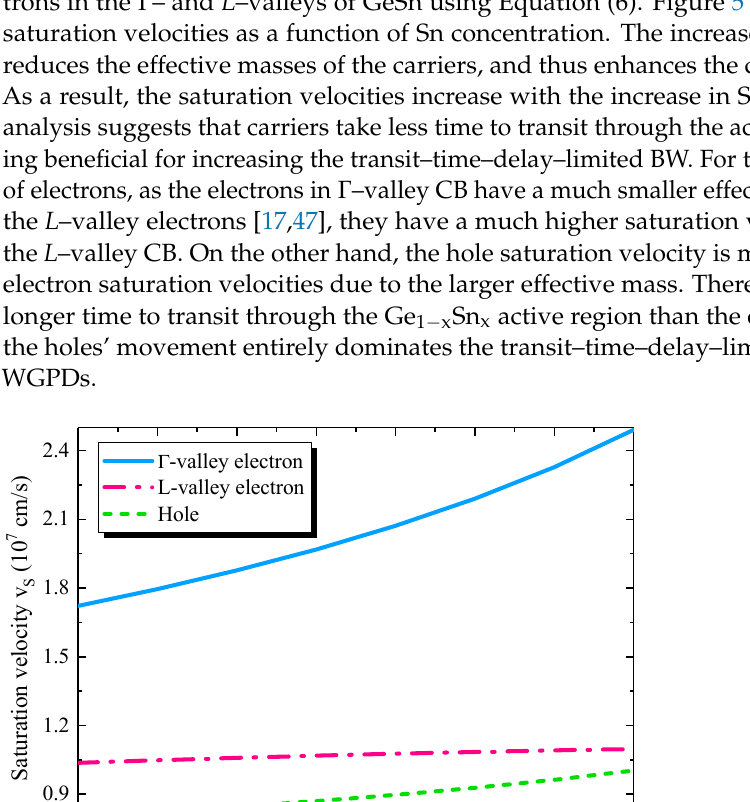
Figure 4. Simulated optical confinement factor for the quasi-transverse-electric fundamental mode for the GeSn active layer as a function of thickness and Sn concentration of the GeSn WGPD at λ = 2 µm.